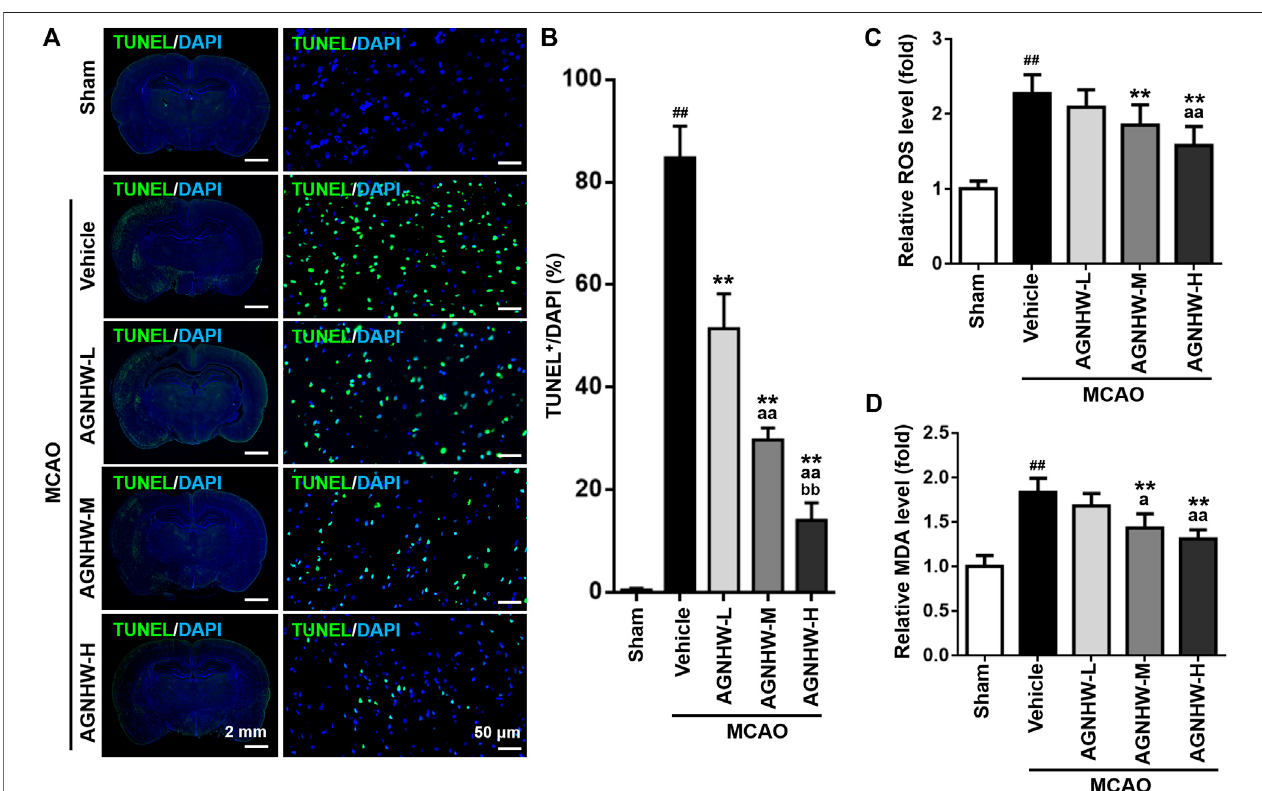
FIGURE 3 | Pre-treatment with AGNHW suppressed cell apoptosis and oxidative stress damage in MCAO model (A,B) Representative images ( A ) and results of statistical analysis ( B ) of TUNEL staining inthe infarct areaof the ischemic cortex in MCAO ratswithor withoutpre-treatment withAGNHW (C,D) The status ofoxidative stress was monitored by cerebral ROS ( C ) and MDA ( D ) levels, analyzed by appropriate assay kits. N (cid:2) 5 rats per group. Data are means ± S.D. ## p < 0.01, compared with sham group; ** p < 0.01, compared with vehicle group; a P < 0.05 and aa P < 0.01, compared with AGNHW-L group; bb P < 0.01, compared with AGNHW- M group.